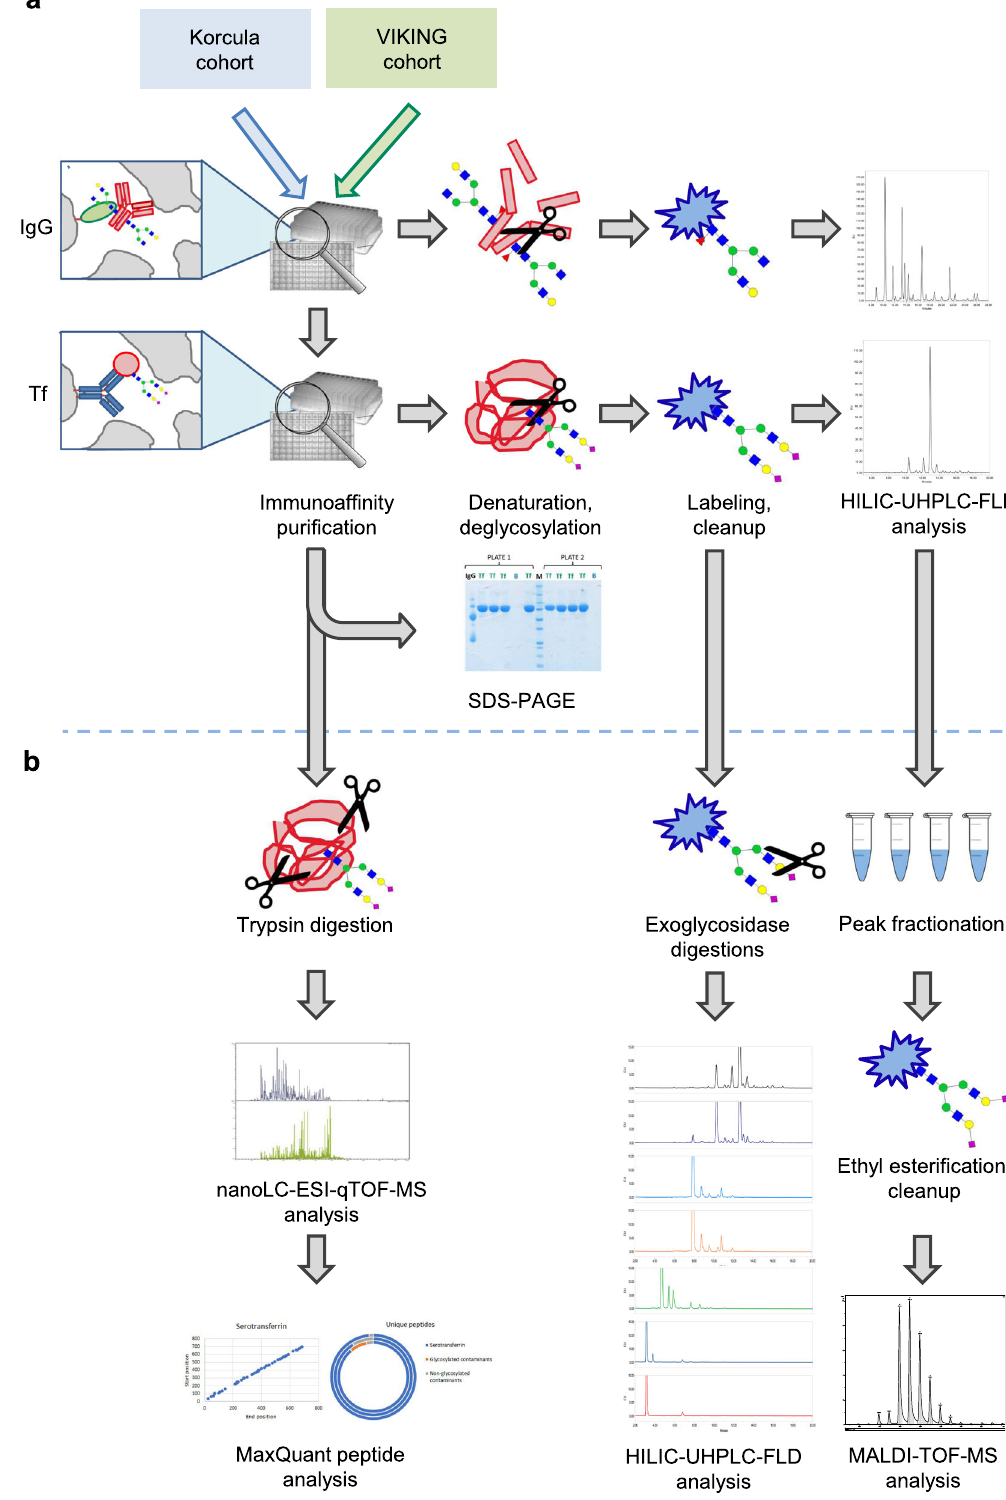
Fig. 1 Work fl ow for human plasma transferrin (Tf) isolation and N-glycan structures characterization. a Sequential isolation and N-glycan pro fi ling of immunoglobulin G (IgG) and Tf from two human populations (Korcula and VIKING). HILIC-UHPLC-FLD ultra-high-performance liquid chromatography based on hydrophilic interactions with fl uorescent detection. b Work fl ow for Tf purity assessment and N-glycan structures characterization by several complementary approaches. nanoLC-ESI-qTOF-MS nano-liquid chromatography coupled to electrospray ionization quadrupole time-of- fl ight mass spectrometry; MALDI-TOF-MS matrix-assisted laser desorption/ionization time-of- fl ight mass spectrometry.